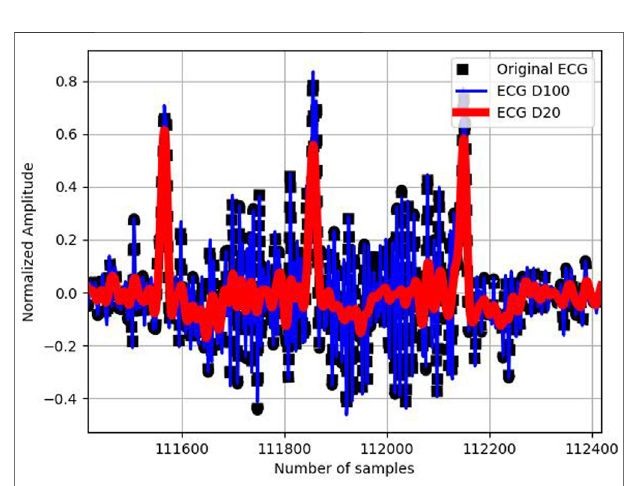
FIGURE 2 | Original ECG signal (in black), its ECG D 100 (in blue) and ECG D 20 (in red) versions. The ECG signal is taken from MITDB: record #104 m.